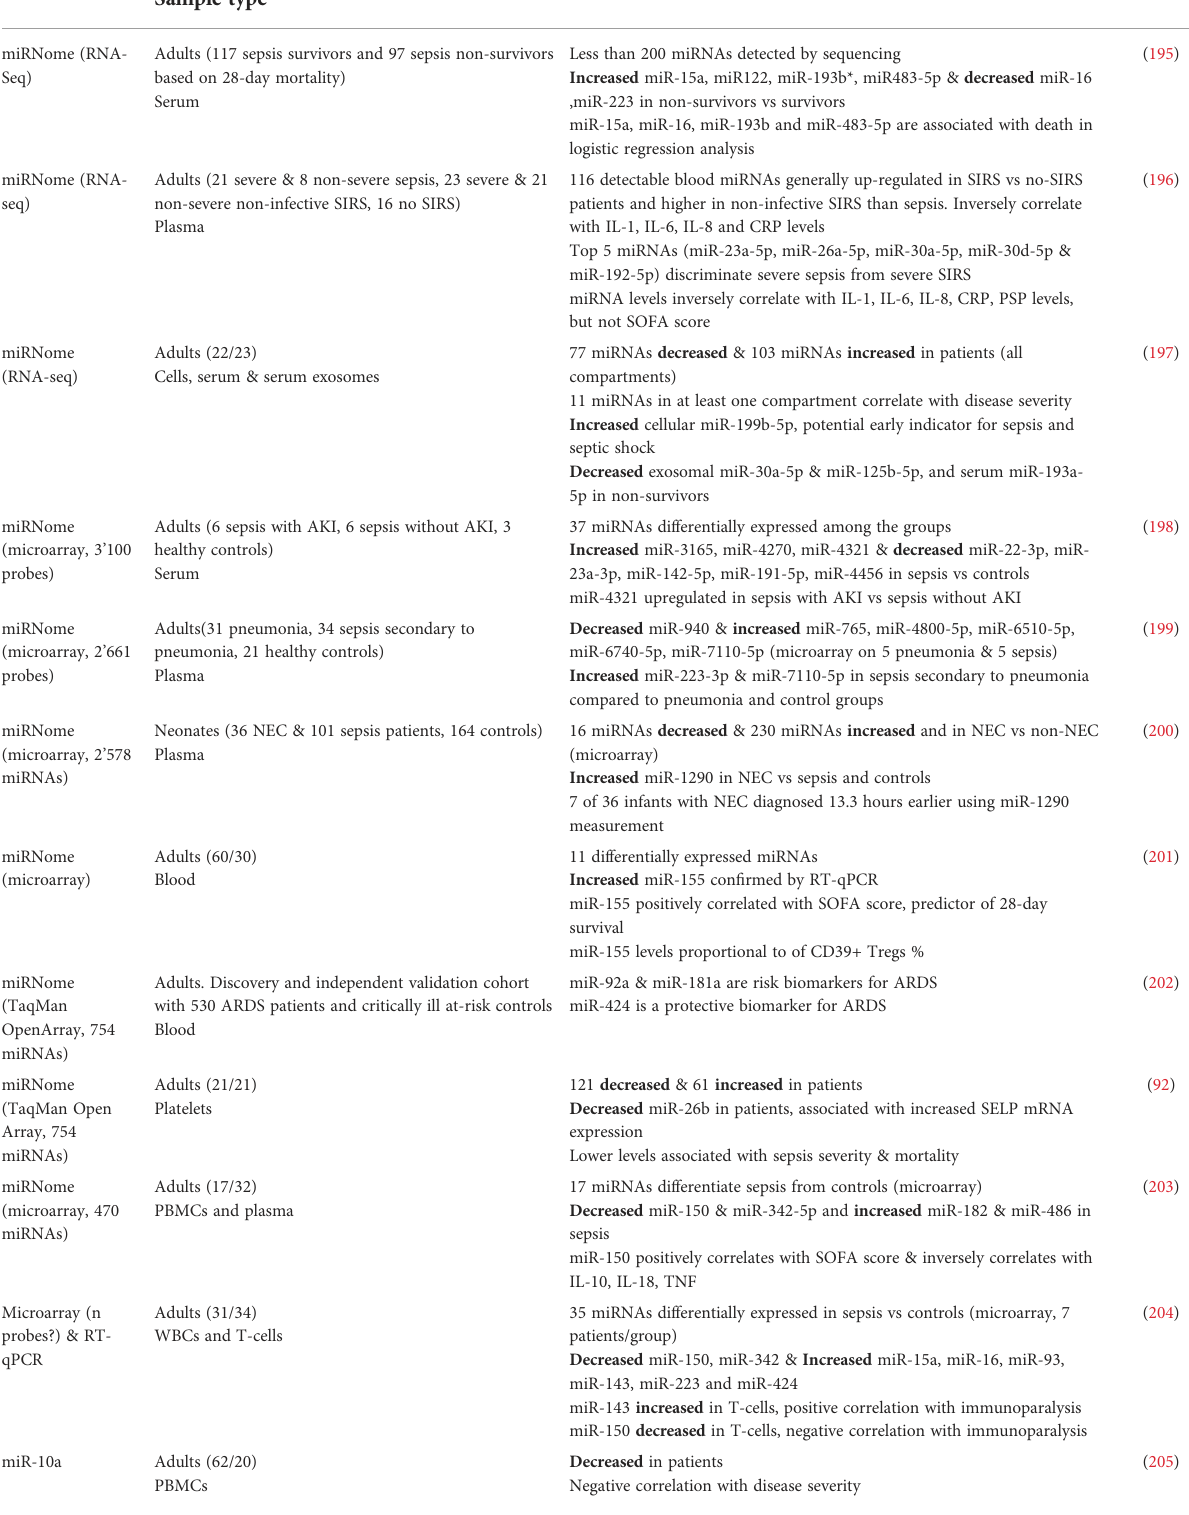
TABLE 2 miRNAs as biomarkers in human sepsis.